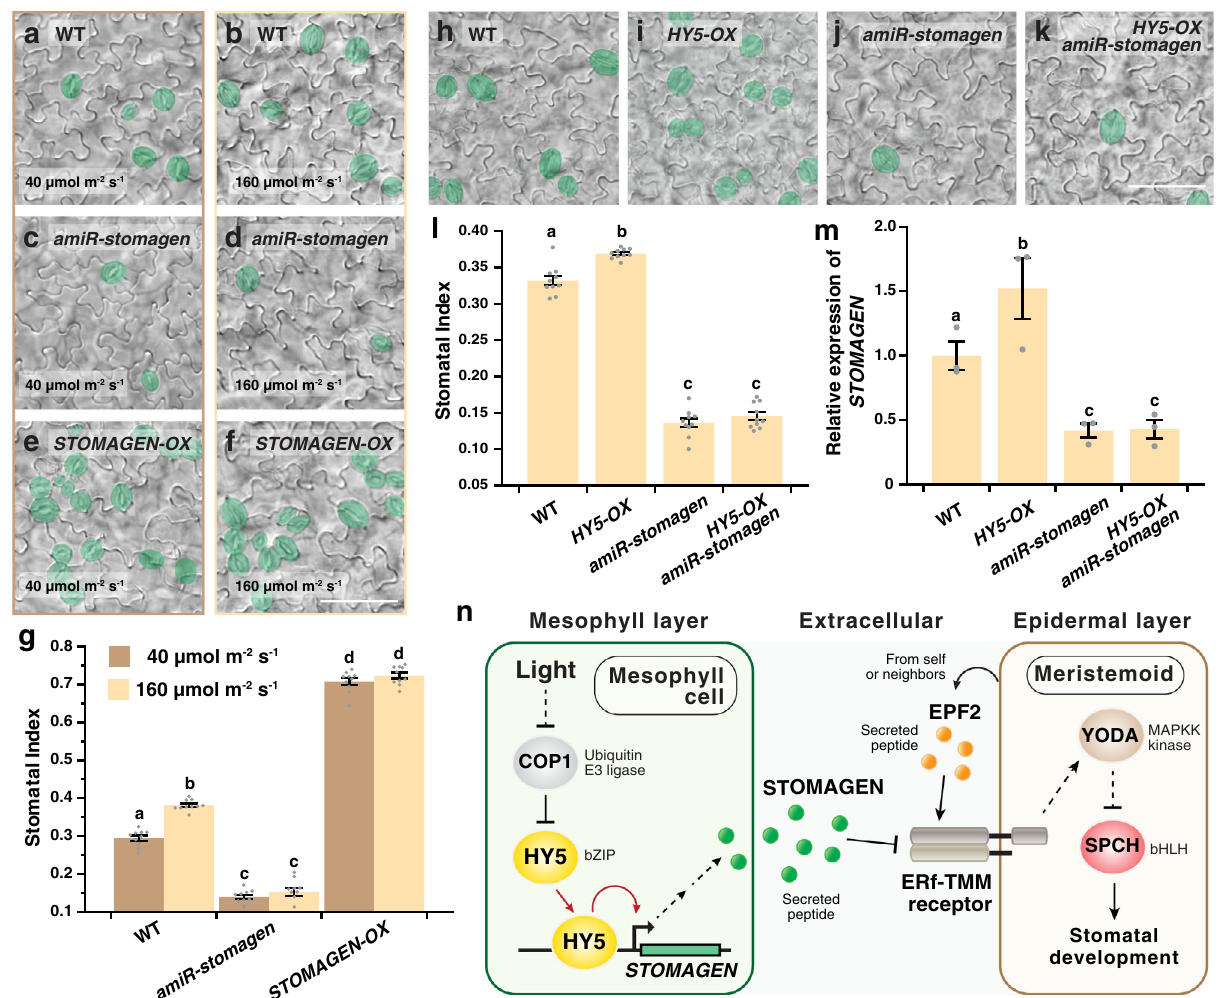
Fig. 5 STOMAGEN is important for the HY5 -mediated promotion of stomatal development. a – g Light-induced stomatal development is impaired in mutants of STOMAGEN . Arabidopsis seedlings of WT, amiR-stomagen (knockdown line of STOMAGEN ), and the overexpressor of STOMAGEN ( STOMAGEN-OX ) were grown for 10 days under either low (40 µ mol m − 2 s − 1 ) or high (160 µ mol m − 2 s − 1 ) light intensity. Representative images ( a – f ) and stomatal indices ( g ) of the respective abaxial cotyledons are shown. h – l Suppression of the stomatal overproduction phenotype of HY5-OX in a knockdown mutant of stomagen . Arabidopsis seedlings of WT, HY5-OX , amiR-stomagen, and the double-mutant HY5-OX amiR-stomagen were grown for 10 days under 100 µ mol m − 2 s − 1 of light. Representative images ( h – k ) and stomatal indices ( l ) of the respective abaxial cotyledons are shown. Stomata are pseudo- colored in green ( a – f , h – k ). Scale bar, 80 μ m. ( m ) Gene expression analysis of STOMAGEN in WT, HY5-OX , amiR-stomagen and HY5-OX amiR-stomagen by RT-qPCR. RNA was extracted from 3-day-old seedlings grown under 100 µ mol m − 2 s − 1 of light. Values are mean + / − SEM, n = 10 independent cotyledons ( g, l ) or three biological replicates ( m ). Two-way ( g ) or one-way ( l , m ) ANOVA with Tukey ’ s multiple comparisons test, P < 0.01 ( g , l ) and P < 0.05 ( m ). n Model of the HY5-STOMAGEN module in promoting light-mediated stomatal development. Light suppresses COP1 and leads to HY5 accumulation. In mesophyll, HY5 binds and induces STOMAGEN . Increased production of STOMAGEN in turn inhibits the repressive signaling pathway of the epidermal stomatal lineage, leading to the accumulation of SPCH and enhanced stomatal